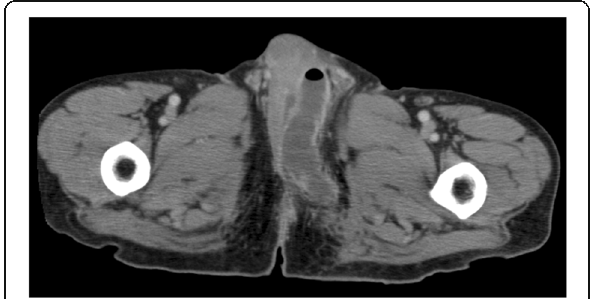
Fig. 1 Computed tomography image shows fluid accumulation with air in the left side of the scrotum, consistent with the findings of a perineal